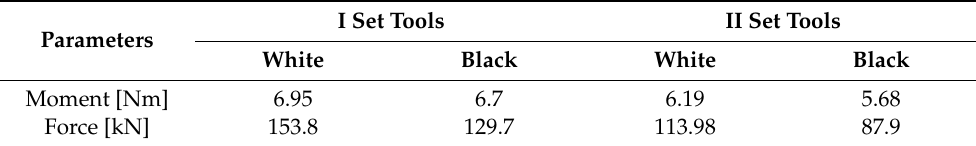
Table 9. Estimated values of rolling process